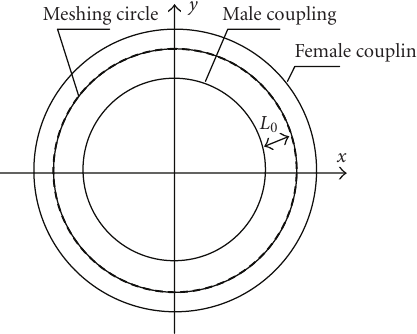
Figure 2: AMD of coupling with no misalignment.